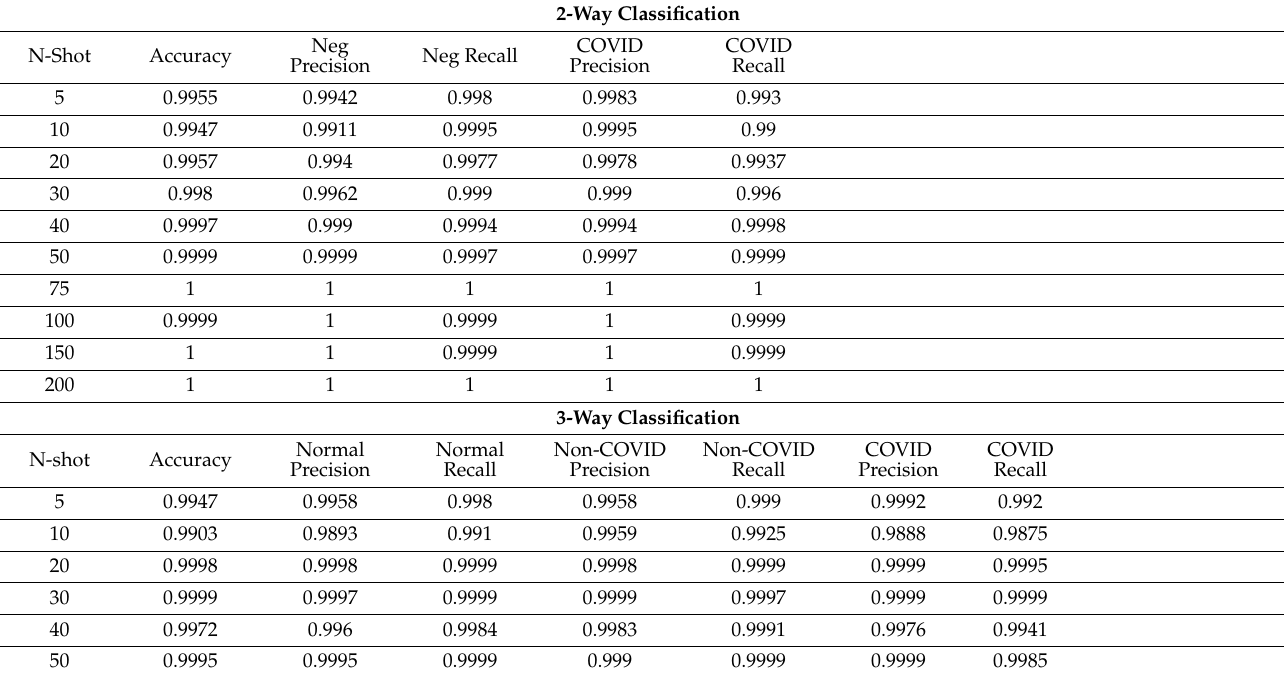
Table A4. Complete experiment results for